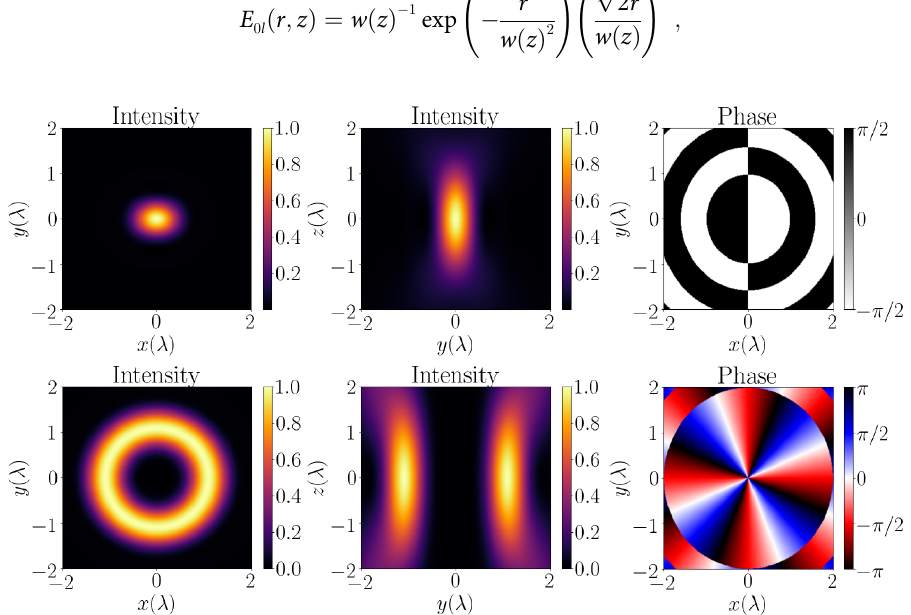
Fig 2. Top: The normalized intensity profile in the (x,y) and (x,z) planes, and the (x,y) phase profile of a linearly polarized LG 00 , or Gaussian mode, reconstructed from the vector spherical wave function expansion. Bottom: The same for a circularly polarized LG 03 mode. In both cases, all planes pass through the origin, numerical aperture NA = 0.8, and the medium is